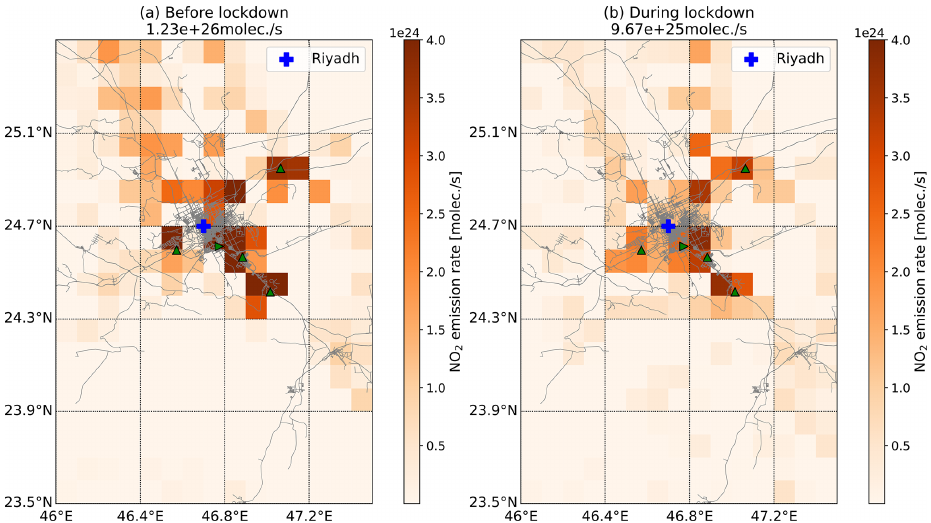
Figure 5. Averaged ML-estimated emission strengths before lockdown (March–June 2019) and during lockdown (March–June 2020). The number in each panel heading presents the total emission rate.